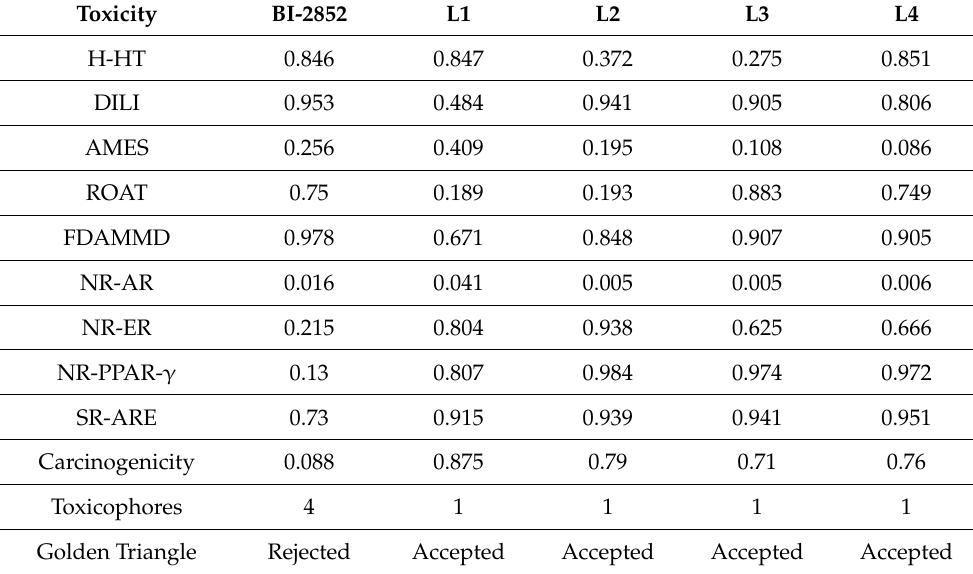
Table 8. Toxicity profiles of top 4 lead